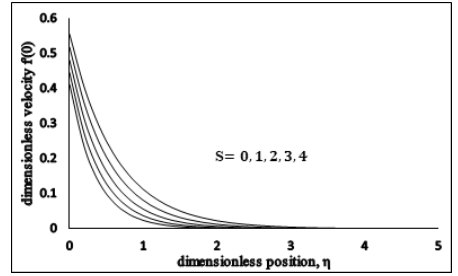
Figure 6. Dimensionless Temperature vs S